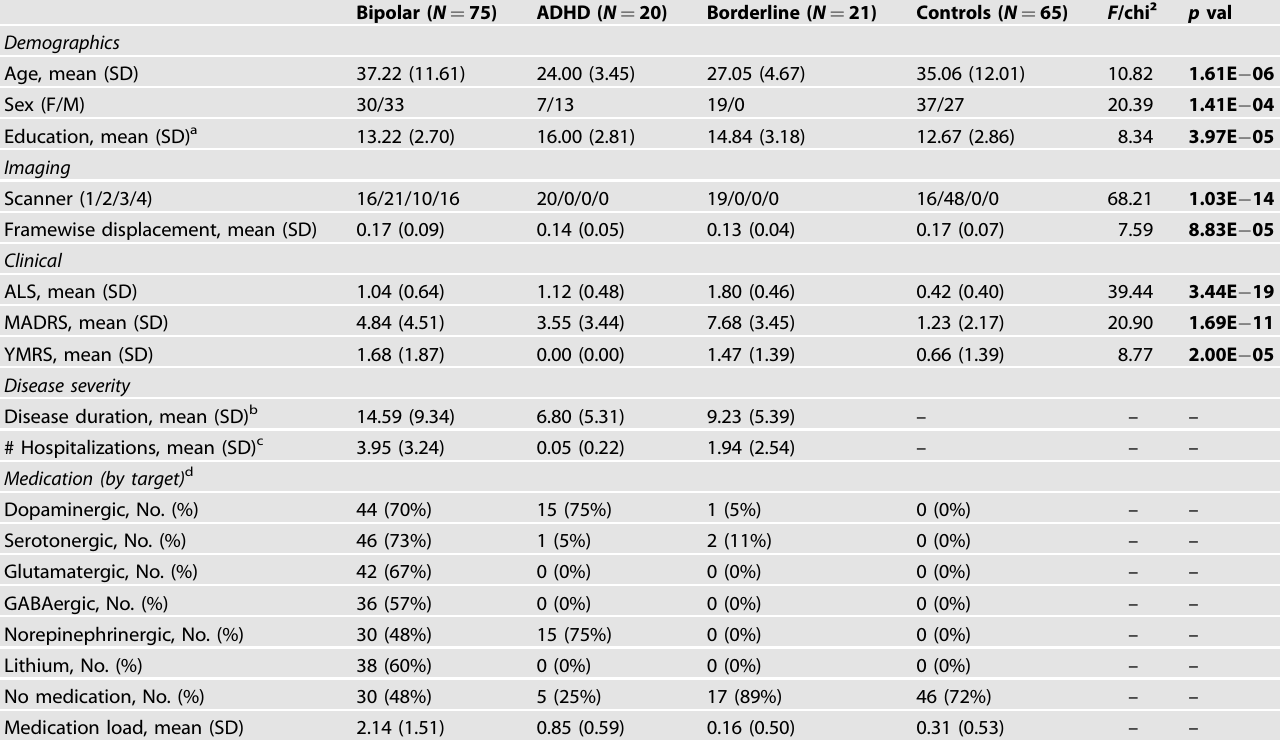
Table 1. Demographic, imaging, and clinical pro fi le of the sample used in the analyses ( N =